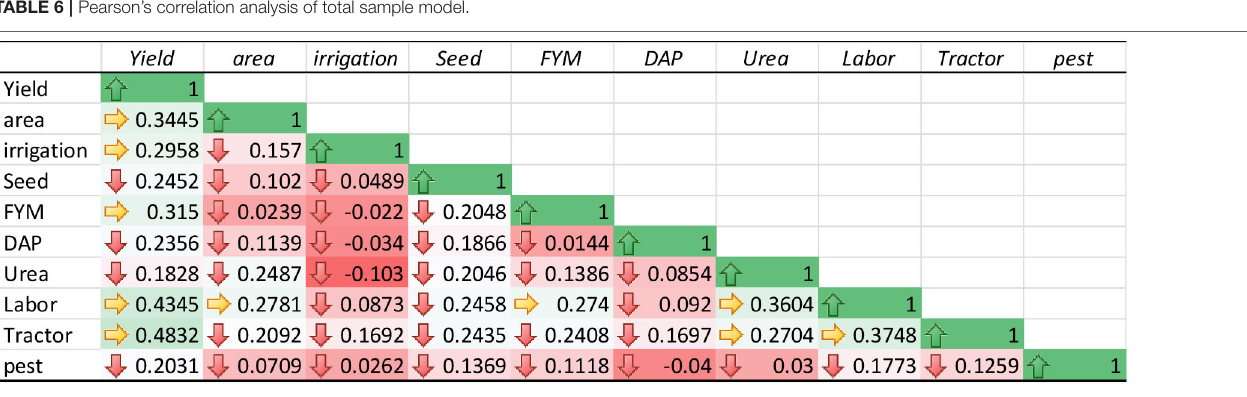
TABLE 6 | Pearson’s correlation analysis of total sample